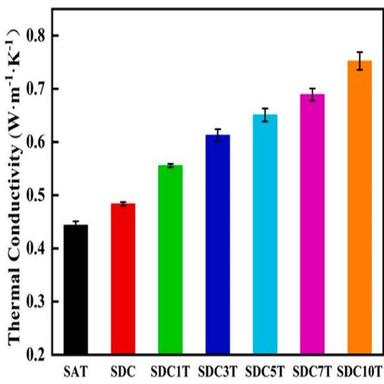
Thermal conductivity of SDC and SDC modified by different contents of Ti4O7.